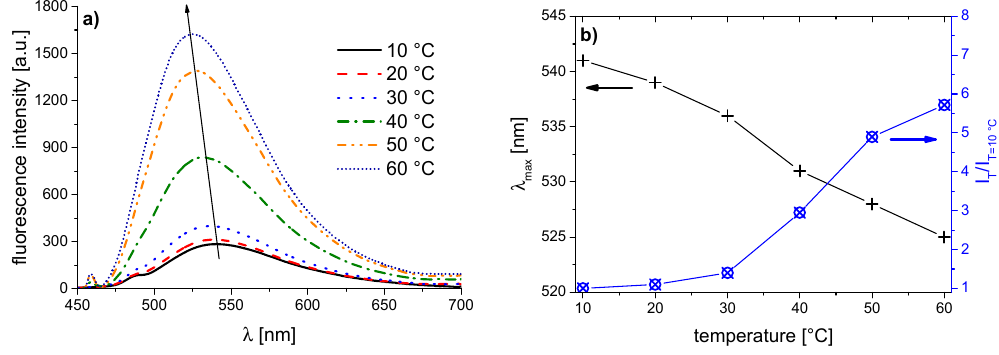
Figure 5. Temperature dependent fluorescence behavior of PNVCL-a in aqueous solution (concentration 0.10 g·L − 1 ): ( a ) normalized emission spectra ( λ Exc = 418 nm); and ( b ) evolution of λ maxEm of the emission band, and of the fluorescence intensity normalized to 10 °C.